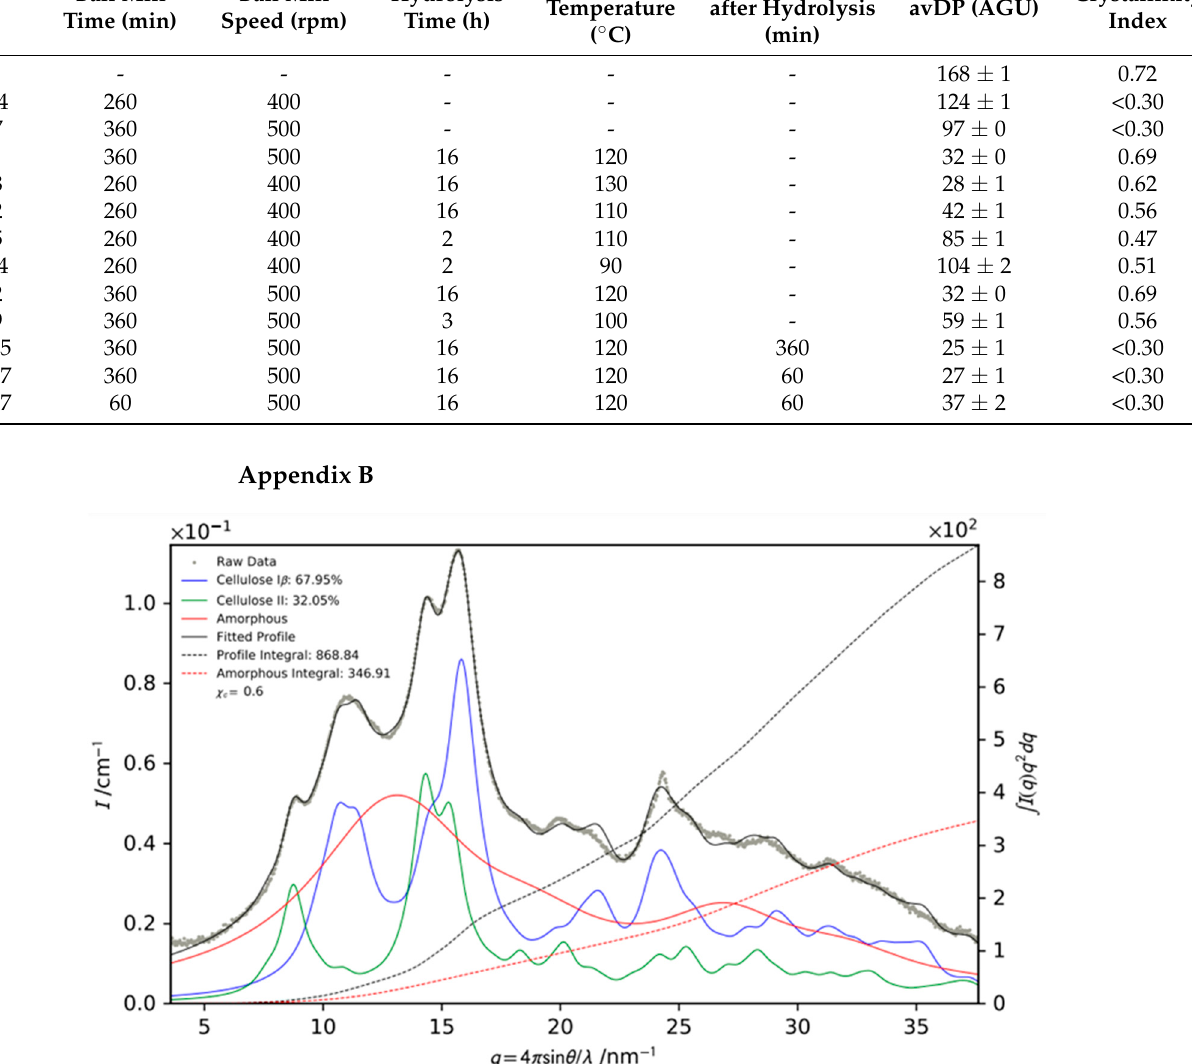
Figure A2. Acetate, butyrate and propionate concentrations, and the relative concentrations of branched SCFA (after 48 h) of cellulose-enriched fecal inocula in the second batch in vitro fermen- tation with pooled human feces, in function of incubation time. DCxx or ADCxx represents the fecal inoculum with the addition of a depolymerized cellulose or amorphized depolymerized cellulose with an average DP of xx . Different letters indicate significant differences between the samples at a certain timepoint ( p < 0.05).